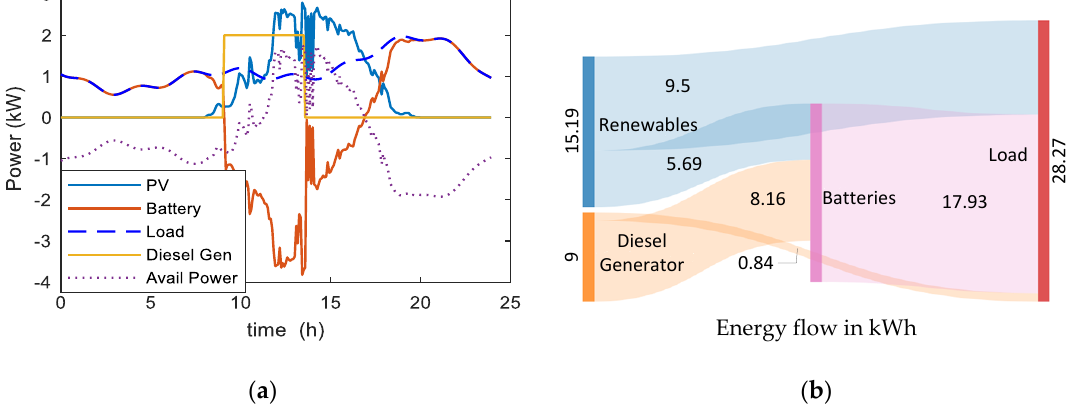
Figure 12. Node 1 at isolated operation (NMPC off) with unpredicted conditions: ( a ) Systems operation; ( b ) Energy flow (kWh).